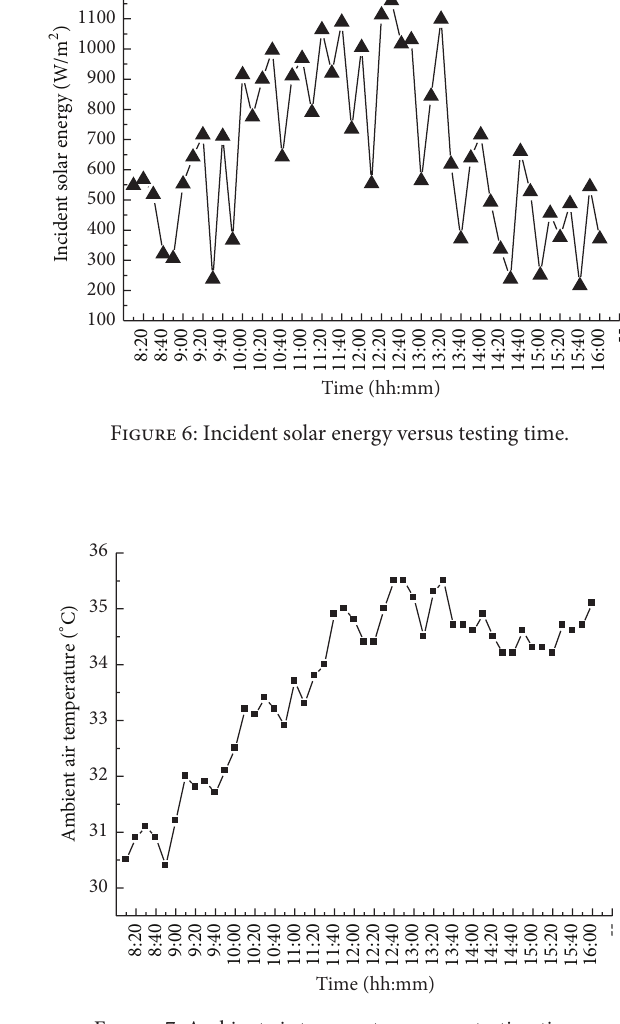
Figure 7: Ambient air temperature versus testing time.